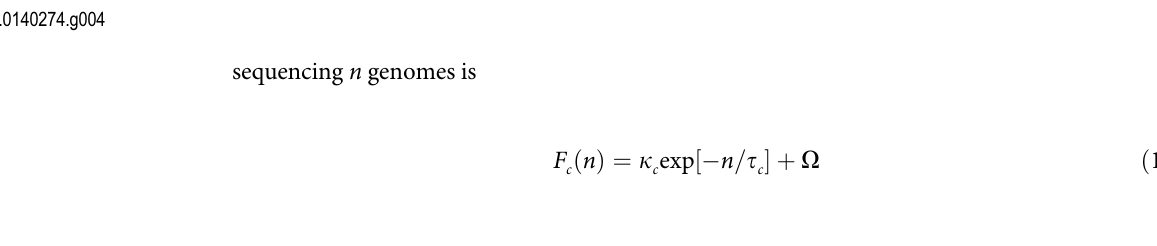
Fig 4. Pan and core genome size. The discovery order of genomes was permuted 100 times with the total number of genes discovered shown in upper series, and number of core genes below. The middle series considers genes to be core if they are present in at least n − 2 of the genomes (extended core). The bottom series considers them to be core only if present in every strain (strict core). Fitted lines for core homology groups are F c ( n ) = κ c exp[ − n / τ c ]+ Ω where Ω is the estimated core genome size (dotted lines: 4,568 homology groups for the extended core, and 2,798 for the strict core). Boxes show medians, interquartile range, and full range of